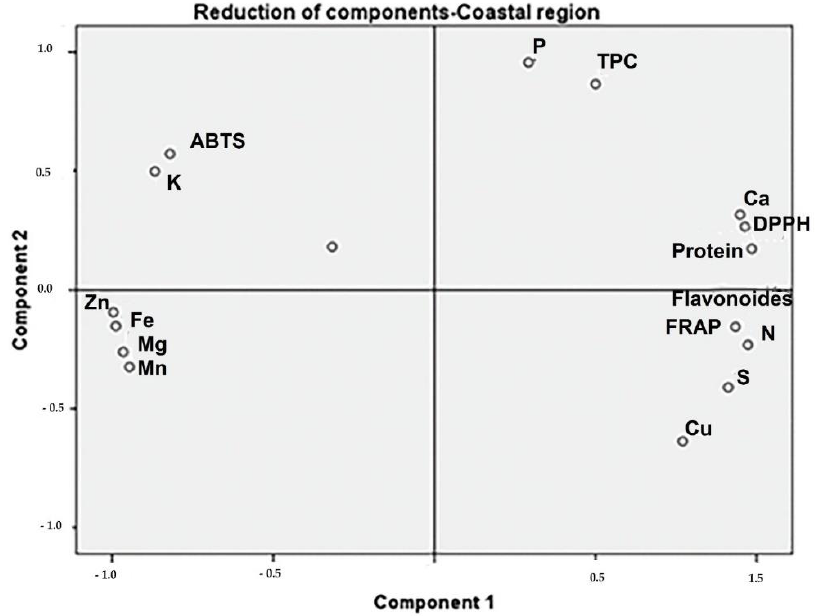
Figure 2. The phytochemical and biological composition of M. oleifera from the Coastal region. Loading plot of PC1 versus PC2, showing the link between DPPH with TPC, calcium, and protein. Legend: TPC — total phenolic content, TFC — total flavonoid content, FRAP — ferric-reducing antioxi- dant power, ABTS — free radical scavenging activity, DPPH — free radical scavenging ability by the use of a stable DPPH • radical.